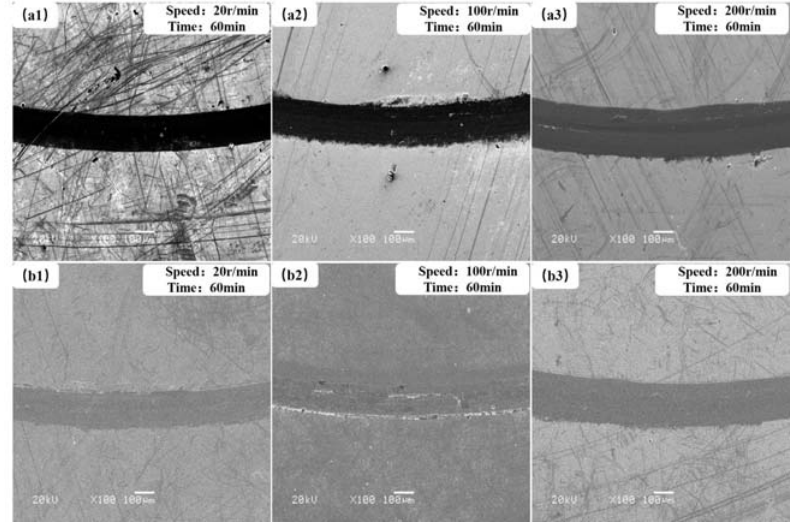
Figure 12. The morphologies of wear tracks for pure MoS 2 film ( a1 , a2 , a3 ) and MoS 2 –WS 2 composite film ( b1 , b2 , b3 ) after AO ‐ irradiation at different sliding speeds.